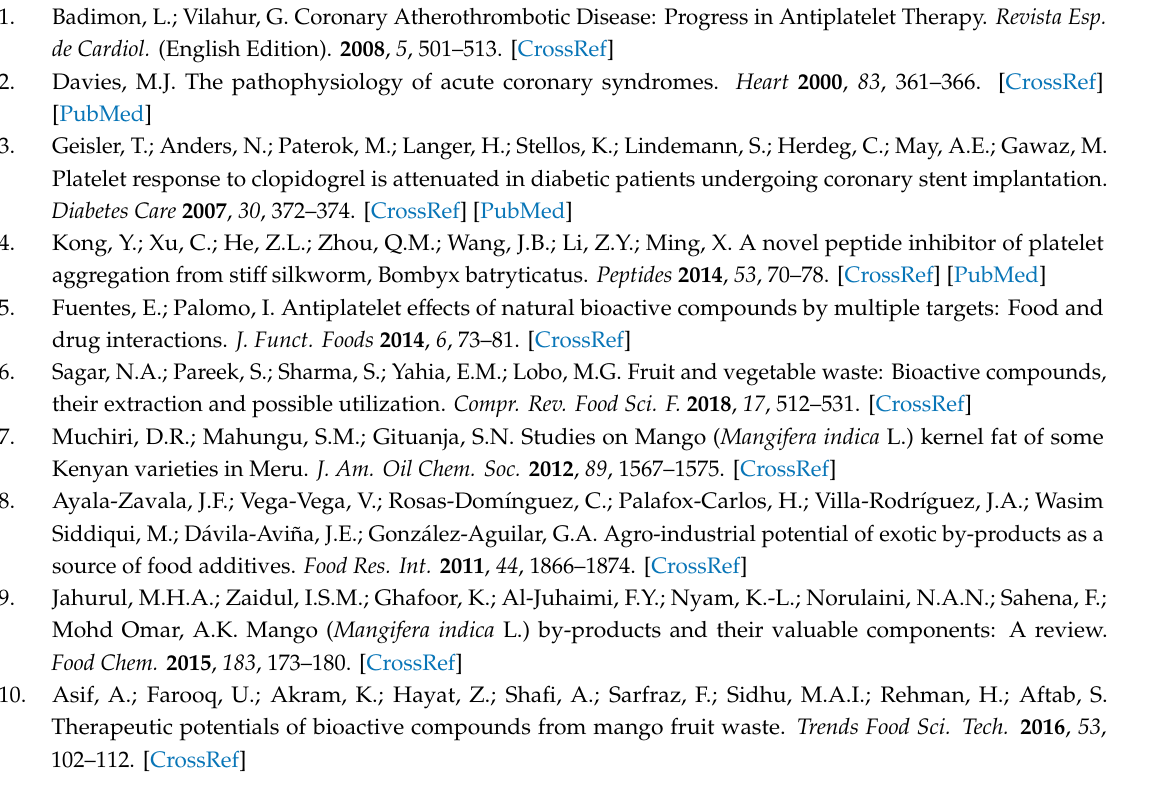
Table S1: Spectral and chromatographic data regarding to the bioactive compounds identified in mango and its by-products by